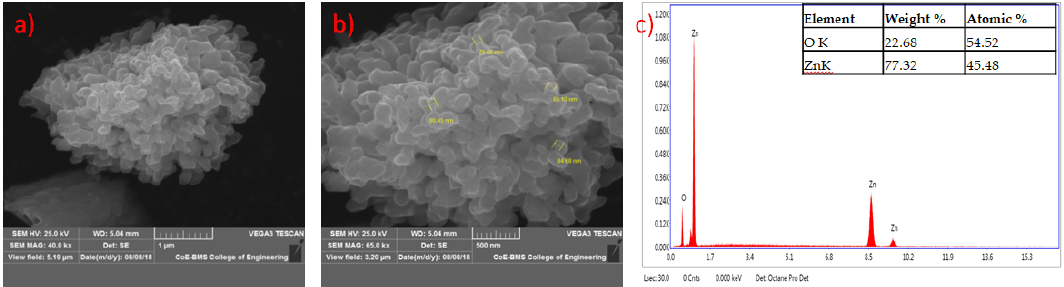
Figure 5. SEM image of zinc oxide nanoparticles synthesized from Trichoderma harzianum (PGT4) at lower ( a ) and higher magnification ( b ); ( c ) represents energy-dispersive X-ray spectroscopy (EDAX) analysis.